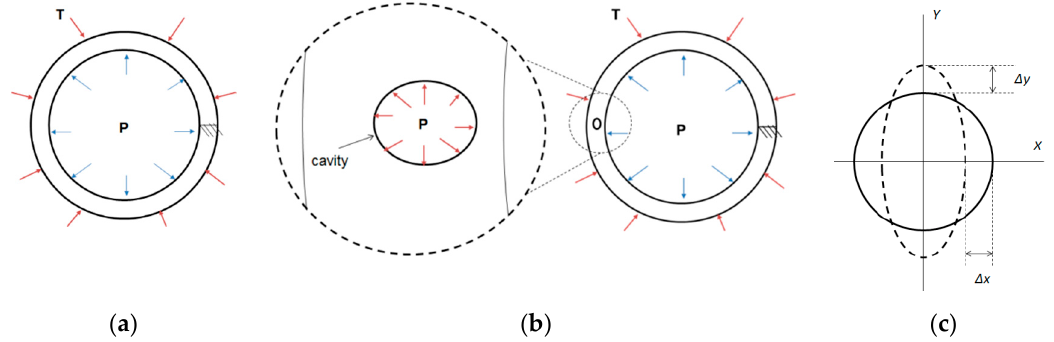
Figure 8. ( a ) Load conditions applied in the first case, ( b ) location of the cavity with internal pressure and ( c ) differences in the horizontal and vertical displacements.